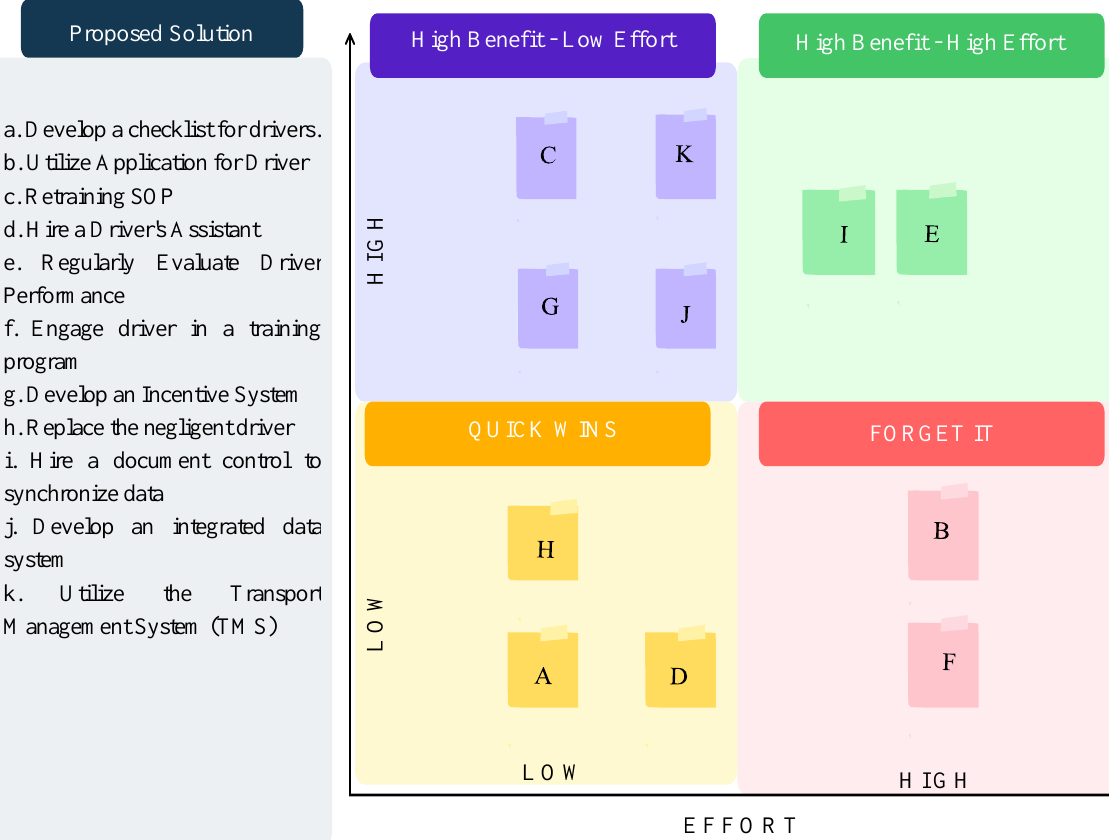
Figure 6: Benefit/Effort Matrix to Proposed Solutions (edited using